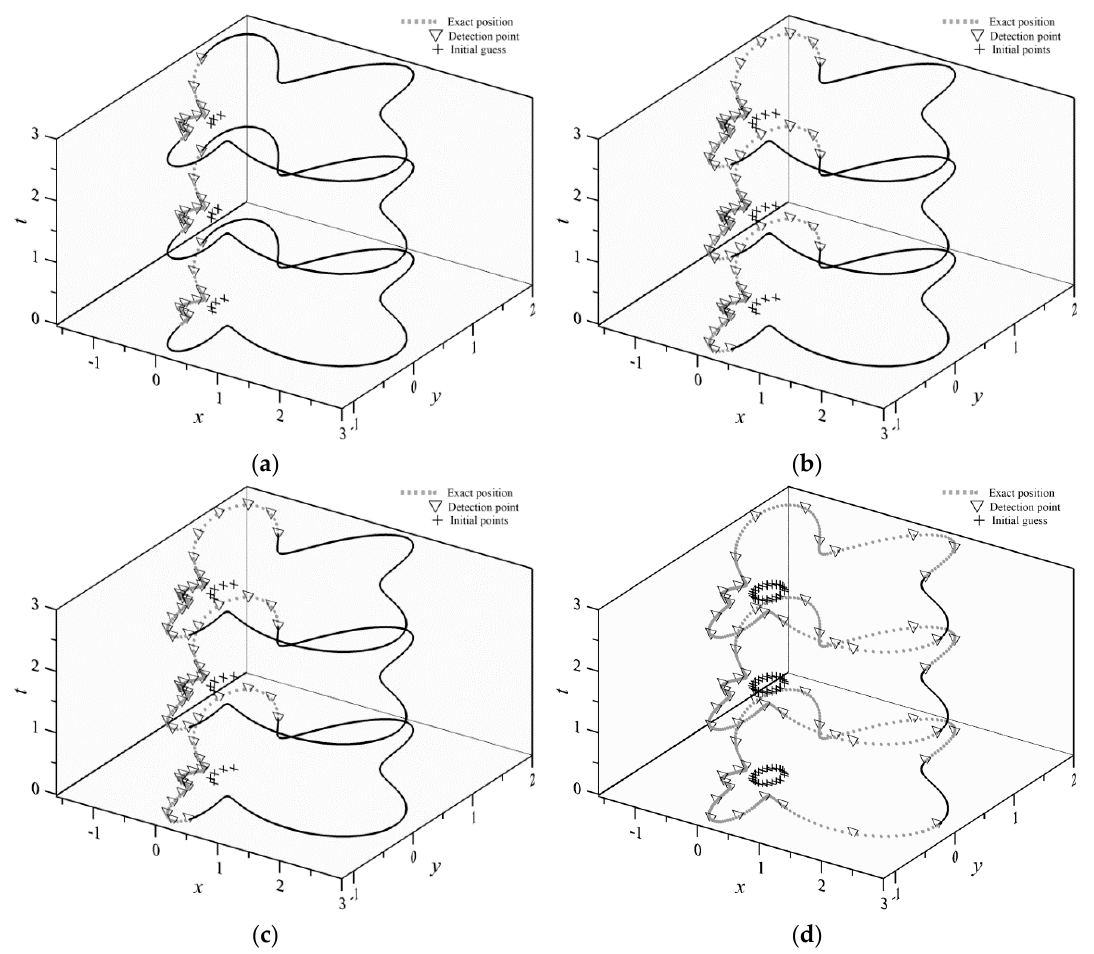
Figure 7. Recovered boundary positions at different times: ( a ) case A; ( b ) case B; ( c ) case C; ( d ) case D.